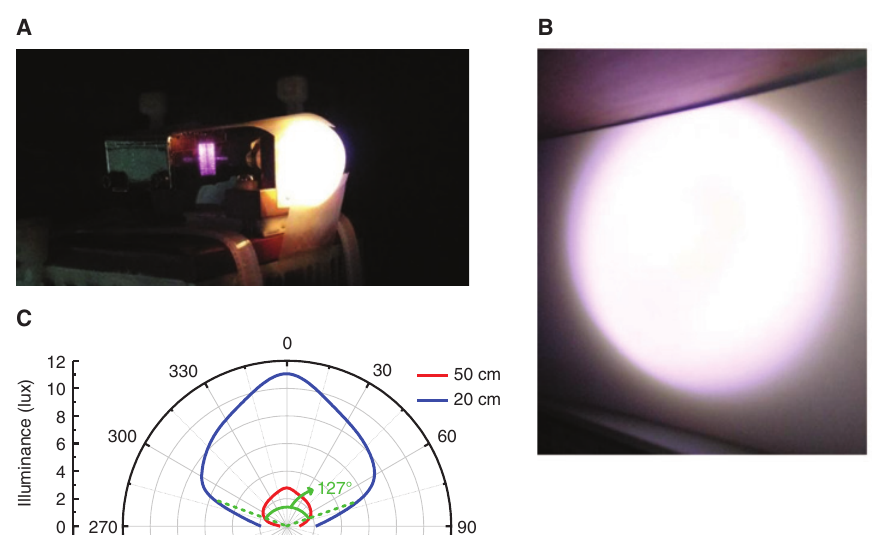
Figure 5: The performance of the white-lighting source constructed by adhering the CdSe/ZnS core-shell-QD doped PDMS film to the VLD output